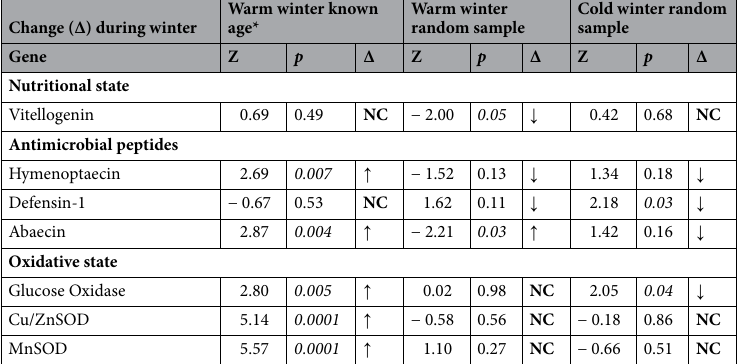
Table 1. Change (Δ) in hypopharygeal gland gene expression over winter. *The change (Δ) in expression during winter compares 19/33 days to 50/70 days of age. In the warm winter and cold winter environments, we compared randomly sampled in-hive workers in early vs. late winter. See Table S3 for